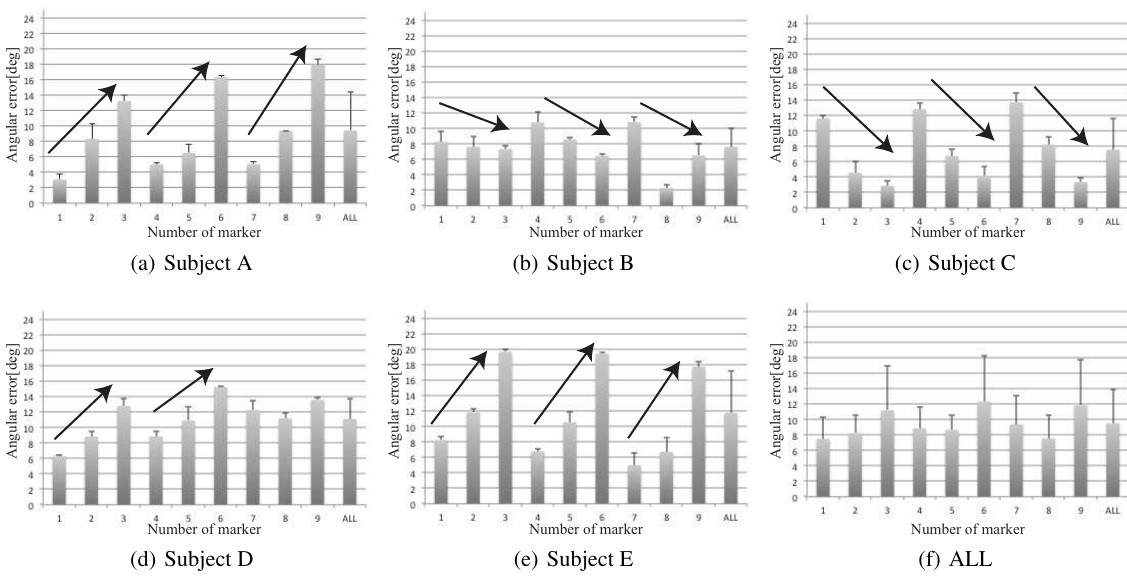
Figure 18 . Average angular error of the estimated point-of-regard in the evaluation